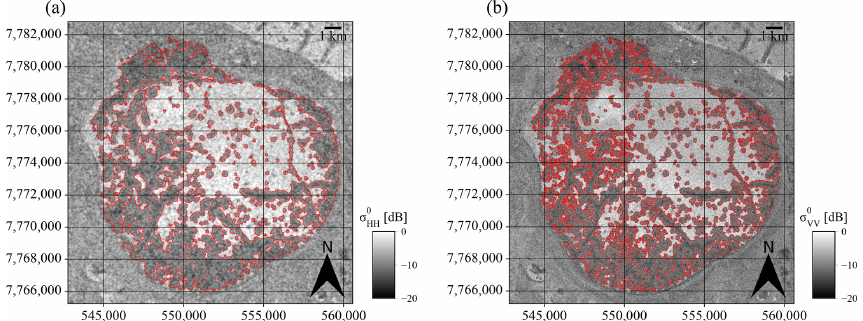
Figure 4. Example of Sentinel-1 EW and IW acquisitions taken 1d apart and classification outcomes of backscatter anomalies. (a) Sentinel-1 EW HH-polarised acquisition from 24 May 2019. (b) Sentinel-1 IW VV-polarised acquisition from 25 May 2019. Red outlines represent polygon outlines from vectorised raster classification maps. CRS: WGS 84 / UTM zone